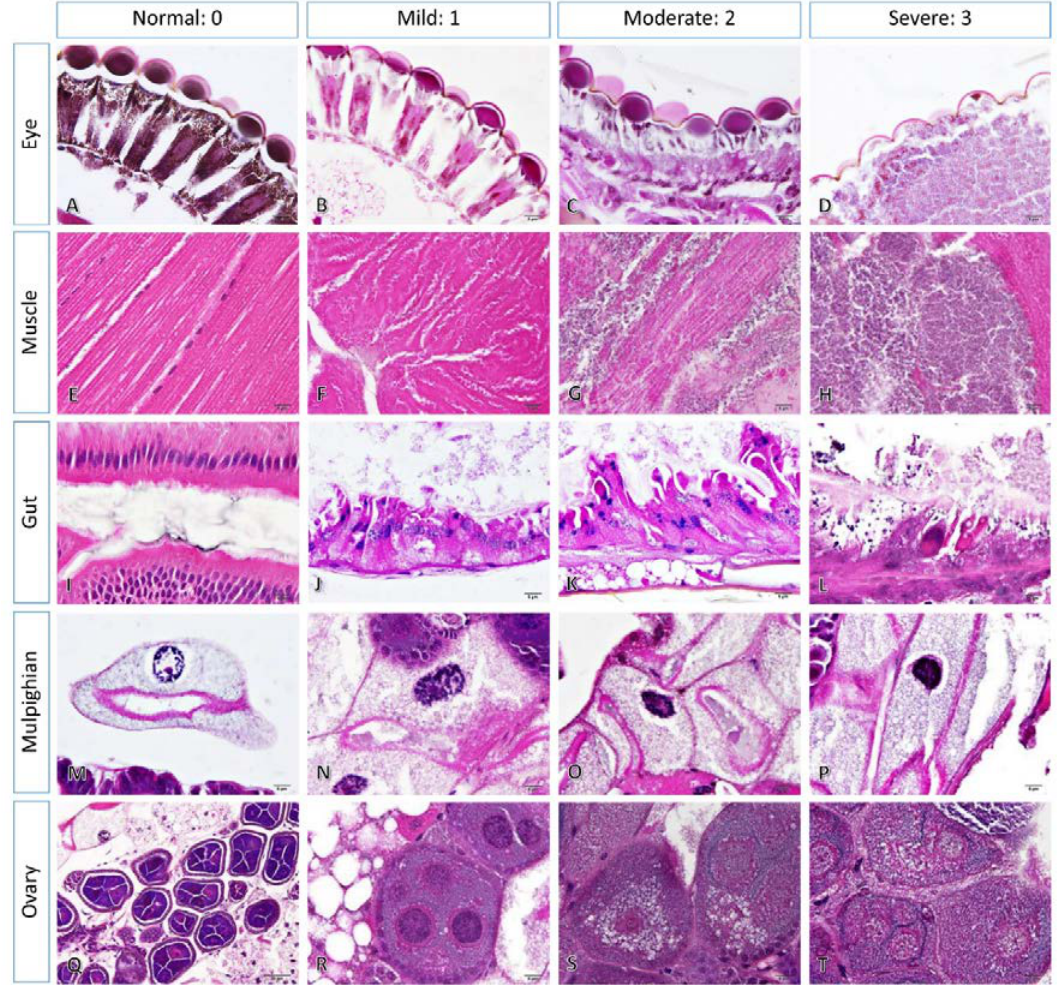
Figure 4. The severity scores of histopathological changes in several tissues of the mosquitoes: Post 24 h of any oil extract exposure, tissue alterations were observed in compound eyes ( A – D ), muscles ( E – H ), intestinal tracts ( I – L ), malpighian tubules ( M – P ) and ovaries. Severity ranged from 0–3; 0 = intact, 1–3 = mild, moderate and severe, respectively. Mild to severe alterations of compound eyes were characterised by the following: (+) the deletion and (++) the collapse of retinal and pigmented cell layers with corneal degeneration ( B and C , respectively) and (+++) total destruction of cornea and retina ( D ). Muscular degeneration was indicated by (+) the loss of striated lines without cellular infiltration ( F ), whereas the loss of striated line with moderate ( G ) to severe ( H ) haemocyte infiltration were categorised as (++) and (+++), respectively. Gut lesion was determined by the absence (+) or presence (++) of lipid degeneration with epithelial destruction ( J and K , respectively) and (+++) severe epithelium loss and necrosis. The levels of pyknotic nuclei in the malpighian cell were identified by the increase in density and distribution of heterochromatin; mild (+), moderate (++) and severe (+++), N to P , respectively. Finally, ovarian degeneration was examined by the distribution of swollen and vacuolated cells; (+) < 25% ( R ), (++) 25%–50% ( S ) and (+++) > 50% ( T ) of observed cells.